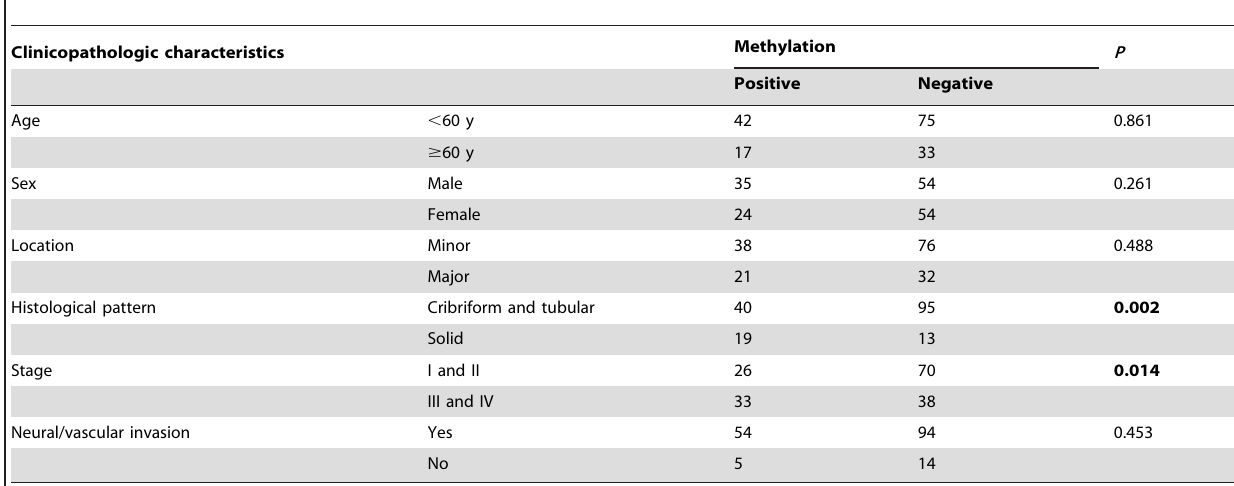
Clinicopathologic